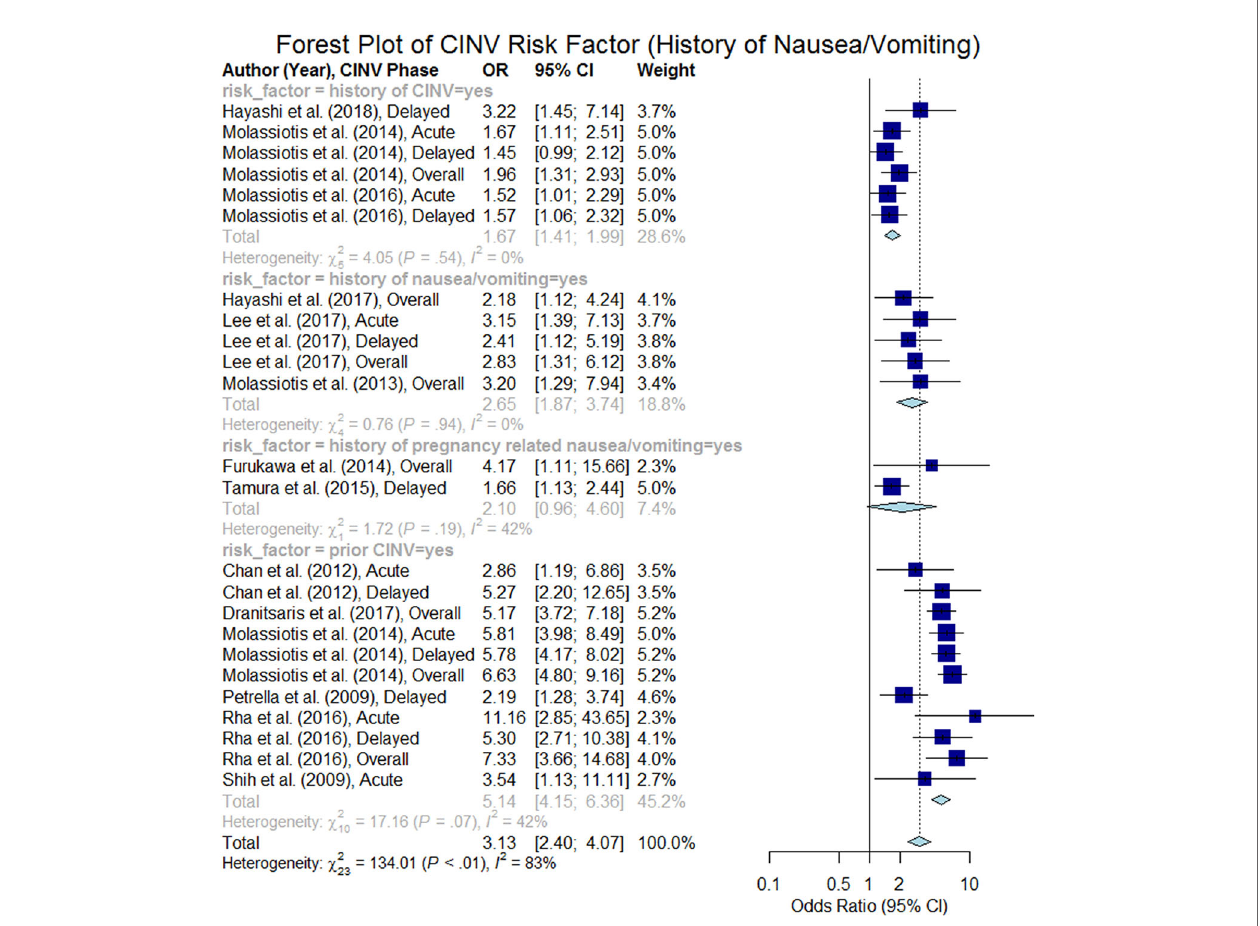
FIGURE 6 | Forest plot of Chemotherapy-Induced Nausea and Vomiting (CINV) risk factor (history of CINV and/or pregnancy-related